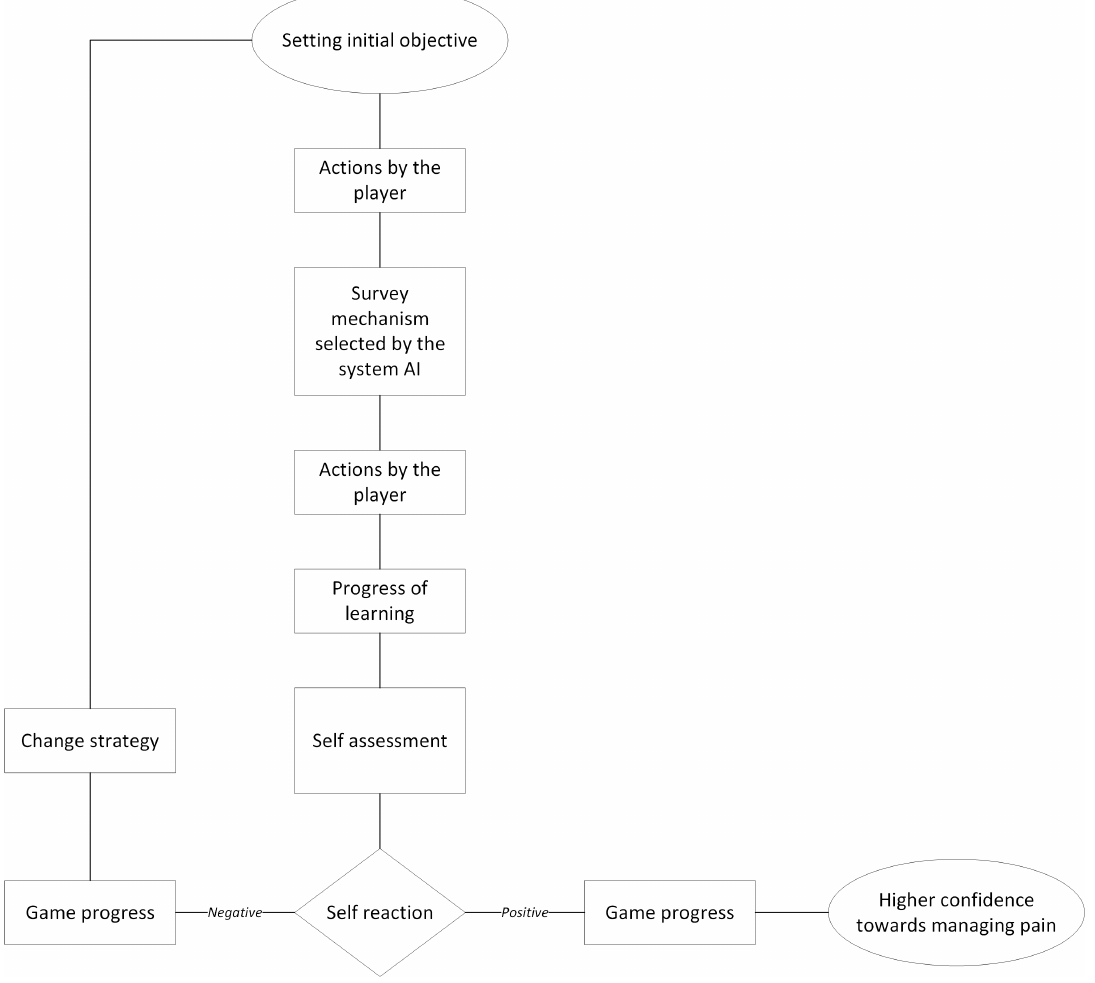
Figure 3. Ontology based scenario